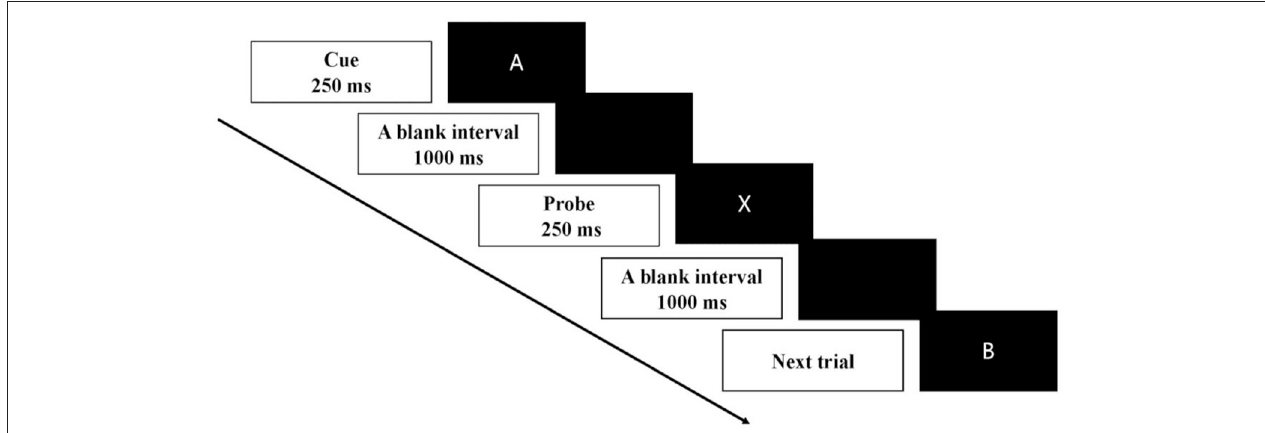
FIGURE 2 | Schematic illustration of the time course of one trial in AX-CPT. Each trial of the AX-CPT began with a cue stimulus of 250ms followed by a blank interval of 1,000ms. The probe stimulus then appeared for 250ms. After the onset of the probe stimulus, the participant was asked to give a response to the probe as soon as possible within